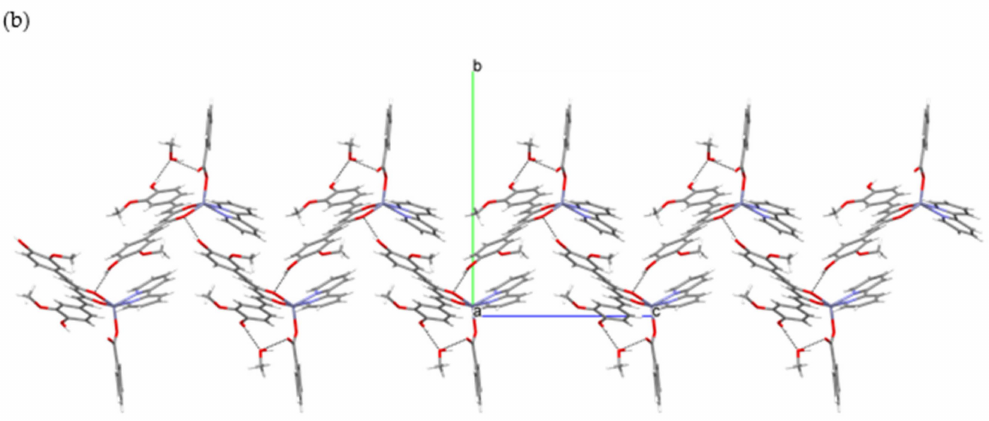
Figure 6. Hydrogen-bonding in [Zn(PhCOO)(cur)(bpy)]( 2 ) · CH 3 OH: ( a ) Section of a layer of hydrogen- bonded [Zn(PhCOO)(cur)(bpy)]( 2 ) and methanol molecules. ( b ) A view of the layer along a axis.